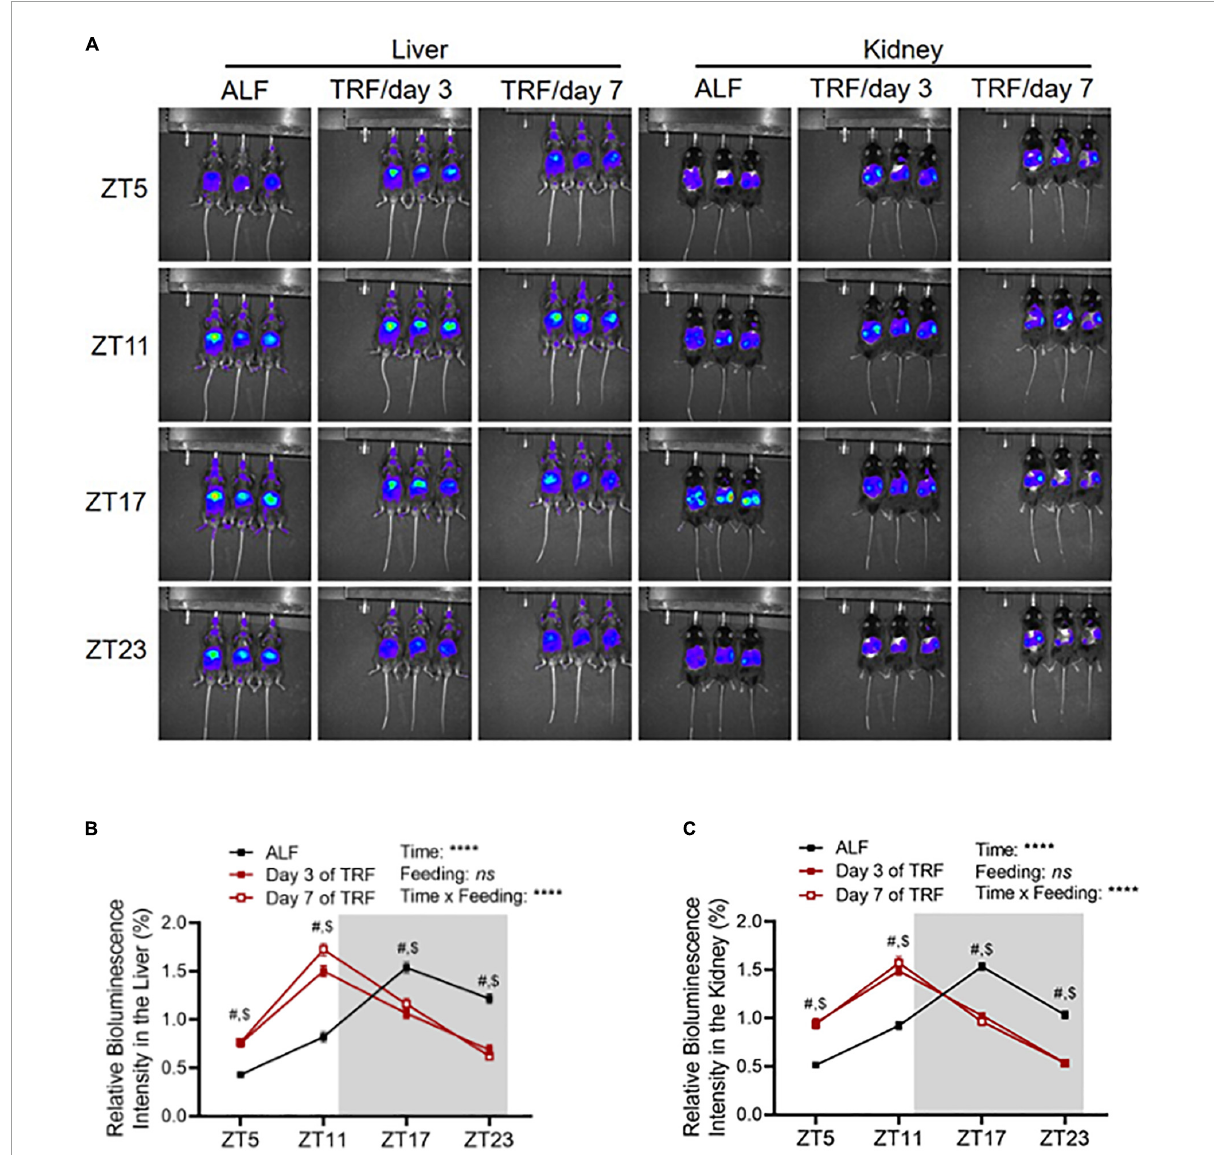
FIGURE3 Light-phase TRF shifts Per2 protein daily oscillation. (A) Representative images of Per2 bioluminescence in the liver and kidney in 17-week-old male mPer2 Luc mice under ALF and at day 3 and day 7 after light-phase TRF. (B,C) Relative Per2 bioluminescence intensity in the liver (B) and kidney (C) under ALF and day 3 and day 7 after light-phase TRF. Data were expressed as the mean ± SEM ( N = 17) and analyzed by repeated two-way ANOVA with matching conditions between ZT and between ALF vs. light-phase TRF with Tucky’s post–hoc analysis (B,C) . #, ALF vs. day 3 after TRF, P < 0.0001. $, ALF vs. day 7 after TRF, P <